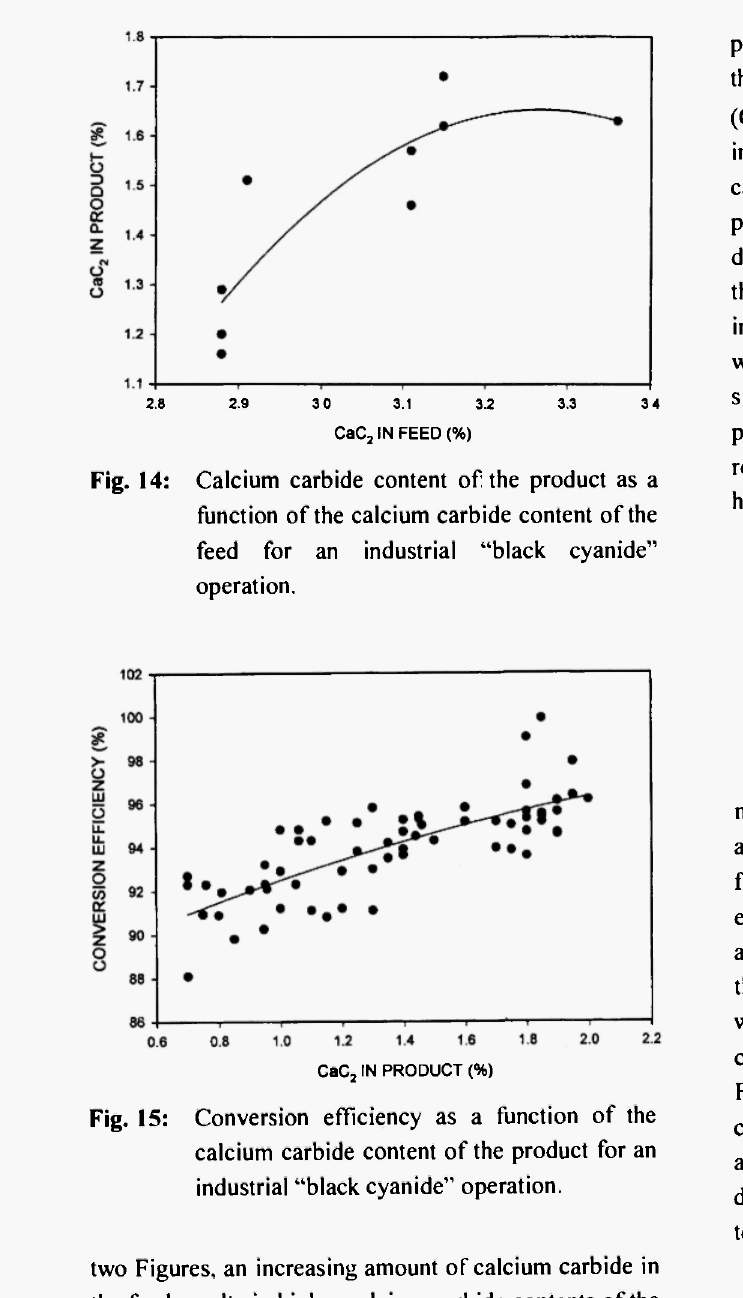
Fig. 15: Conversion efficiency as a function of the calcium carbide content of the product for an industrial "black cyanide"